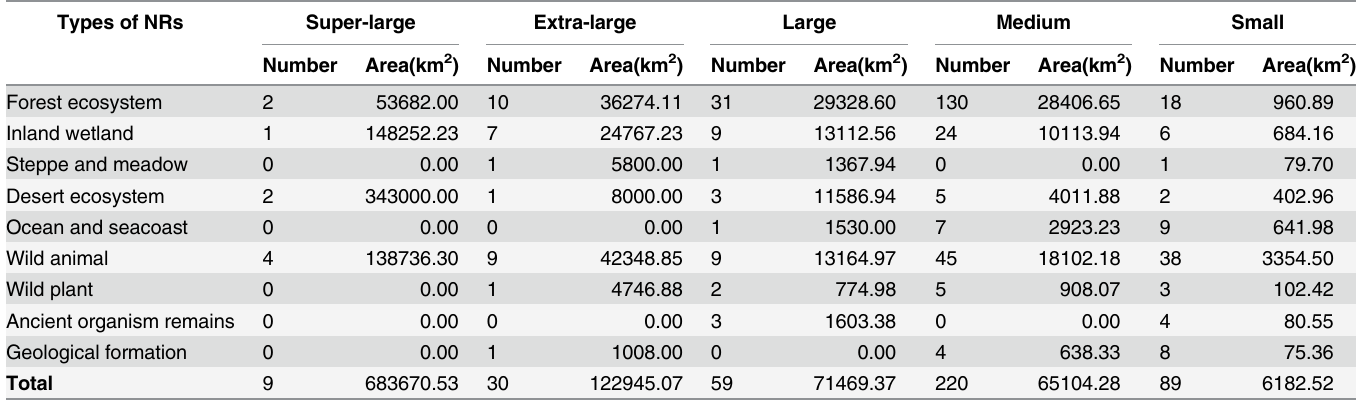
Table 5. Statistics for NNR sizes in mainland